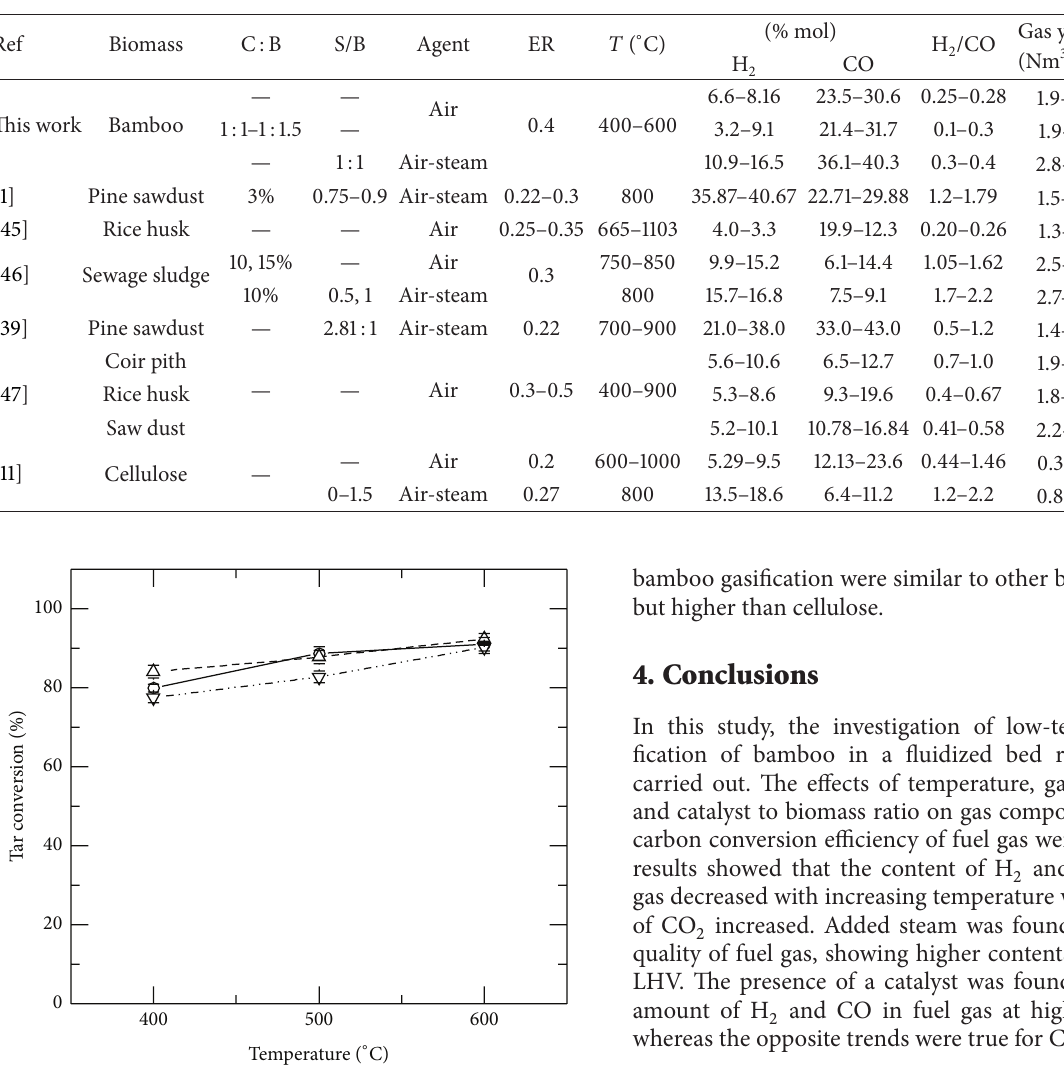
Table 2: Comparison with the existing literature.